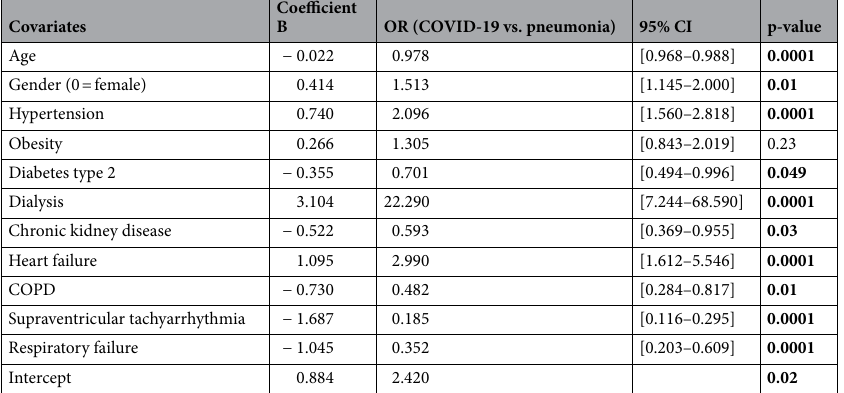
Table 4. Logistic regression analysis for the comparison between COVID-19 and pneumonia death groups. In bold the p-values that reached the statistical significance.